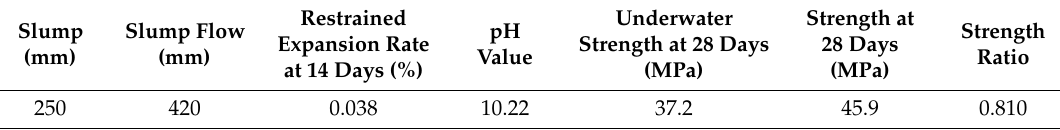
Table 11. Properties of self-stressed anti-washout underwater concrete (SSAWC) with basic mix ratio.